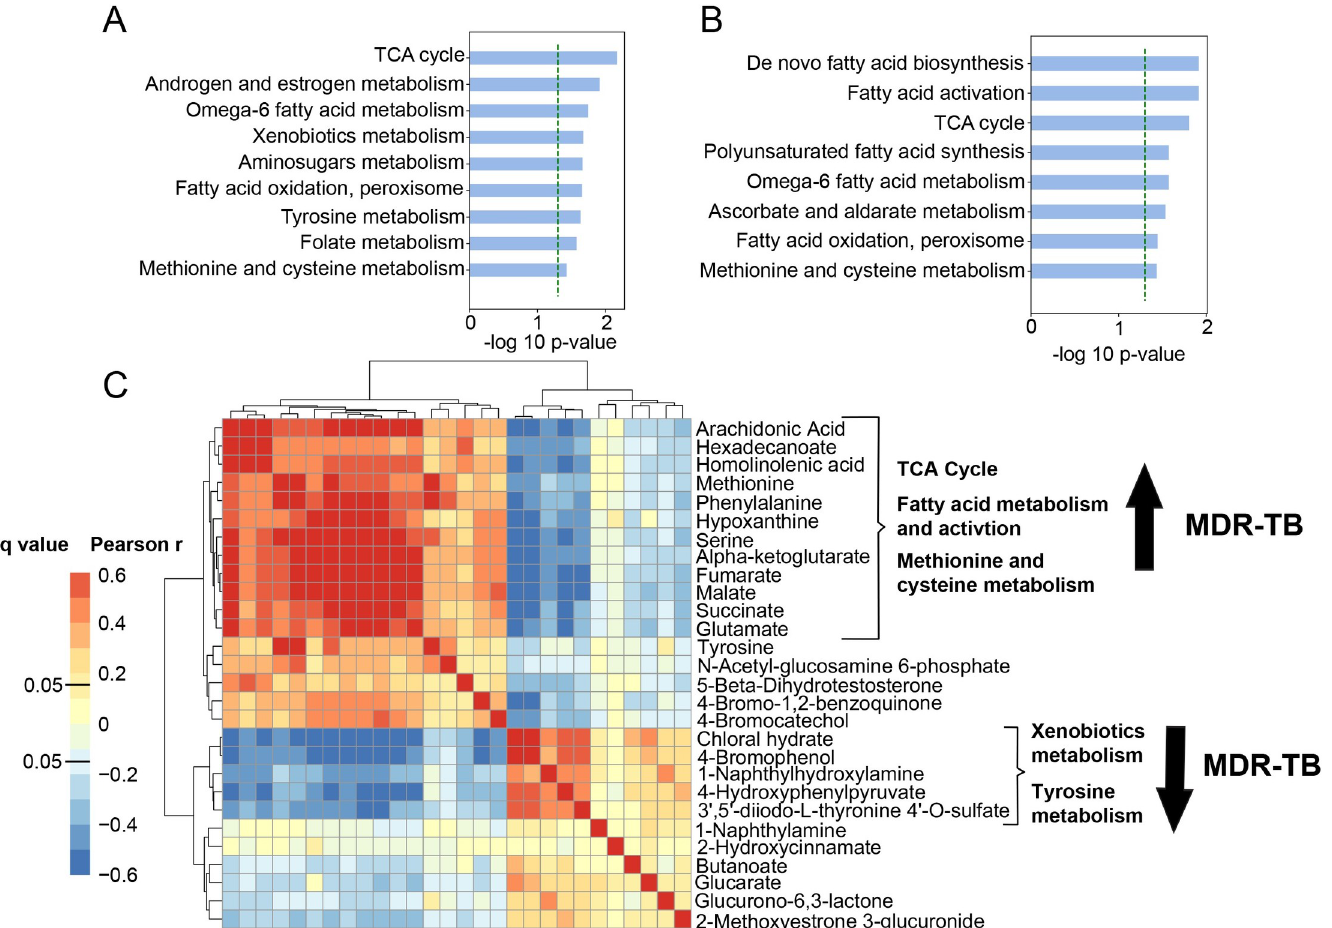
Fig 1. Metabolic pathway regulation in MDR-TB. (A) Unbiased pathway analysis using plasma HRM with C18 negative chromatography to compare the metabolome of persons with multidrug resistant (MDR)-TB (n = 85) to (A) asymptomatic controls without TB disease (n = 57) and (B) persons with drug susceptible (DS)-TB (n = 89) shows TCA cycle metabolism and multiple overlapping pathways in fatty acid synthesis, activation and metabolism were the most significantly regulated pathways in MDR-TB. The y-axis shows significantly regulated metabolic pathways and the x-axis shows the -log p-value for pathway enrichment adjusted for age, sex and HIV status. (C) Correlation analysis of primary metabolite adducts (M-H) mapping to significant pathways reveals a network of highly correlated metabolites involved in the TCA cycle, fatty acid metabolism and methionine and cysteine metabolism that were significantly increased in persons with MDR-TB.